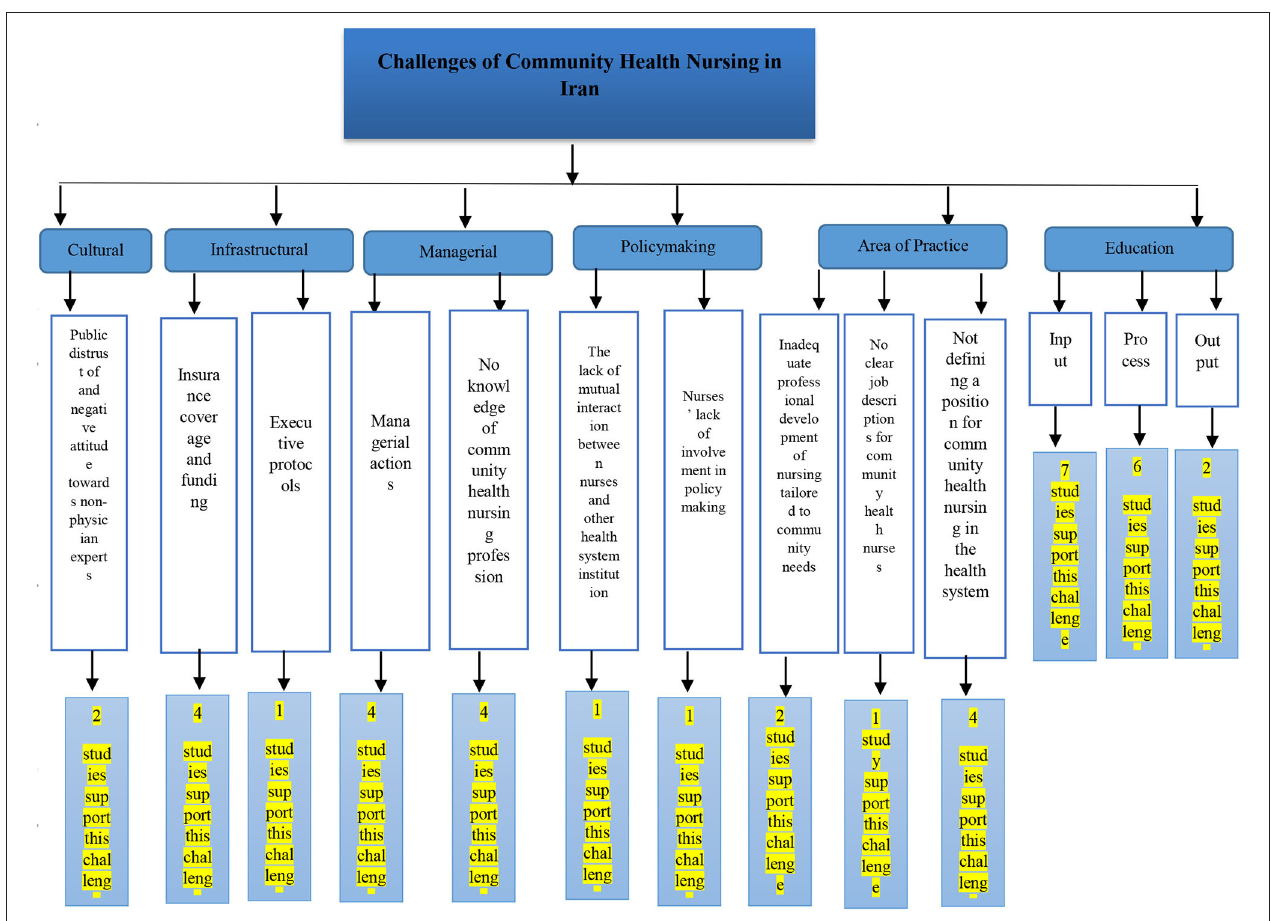
FIGURE 2 | Community health nursing challenges in